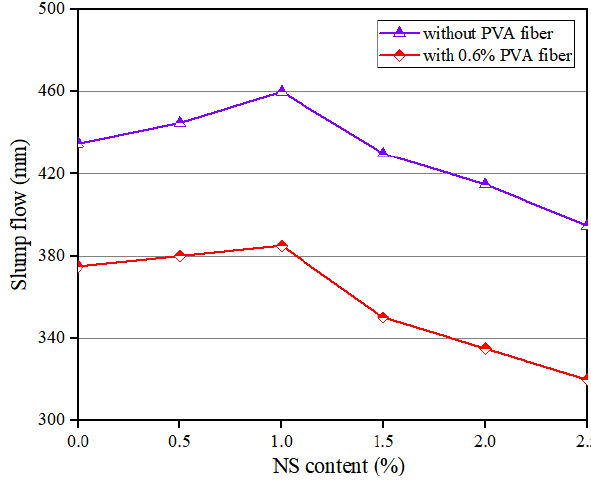
Figure 3. Influence of NS on flowability of geopolymer composites.